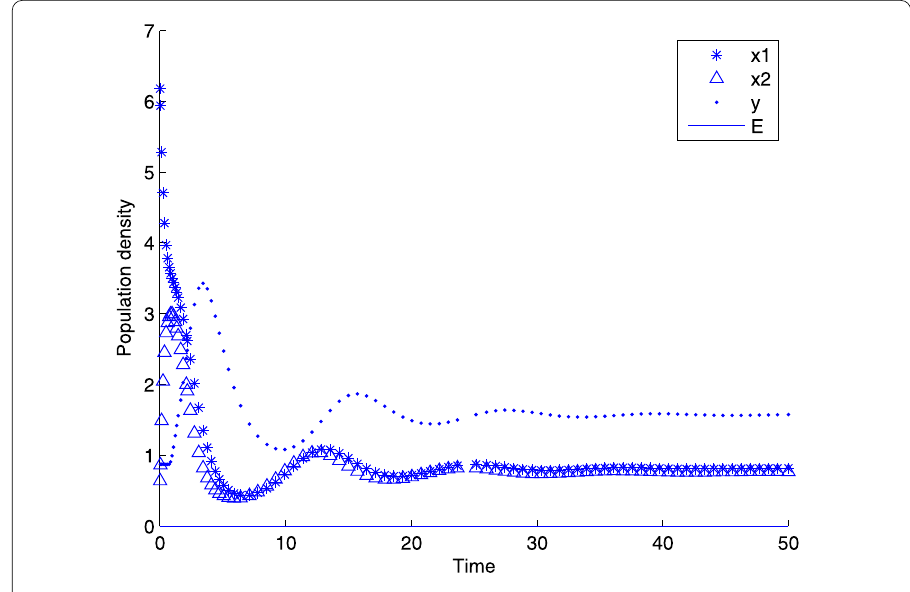
Figure 2 The state response of system (4) with τ = 0.1 at P 3 . The state response of system (4) with τ = 0.1 at P 3 .